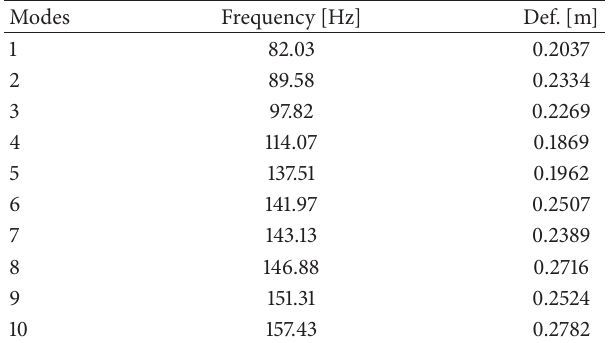
Table 1: Ten modes of vibration.